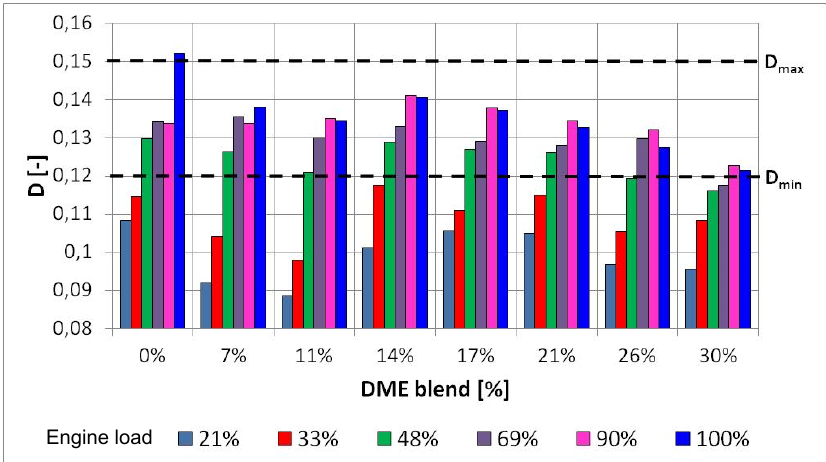
Figure 8. Maximum values of the dynamics factor for different mass fraction of DME and engine load.